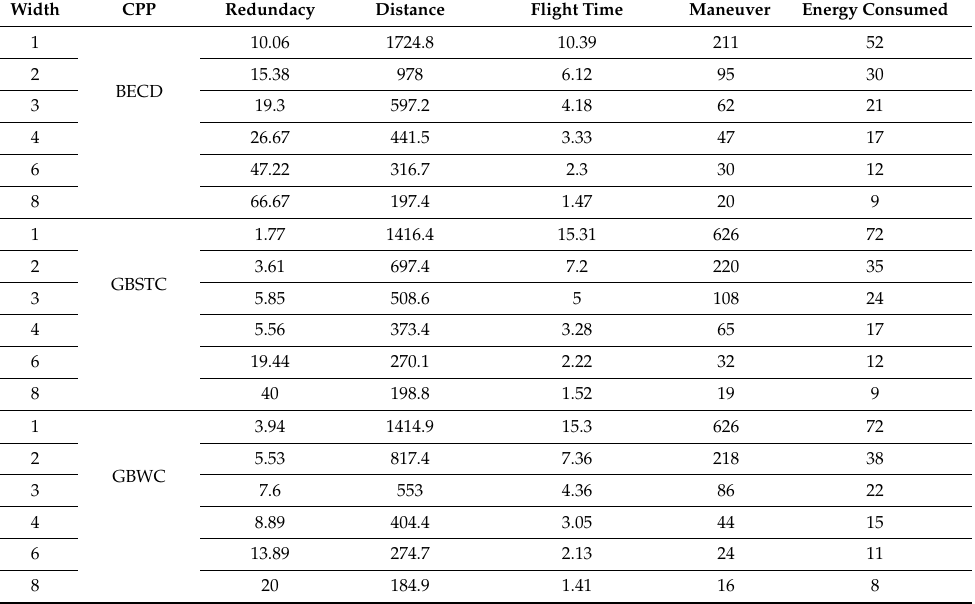
Table A8. Experiment 6 with three CPP methods implemented using the UAV 3DR Iris over